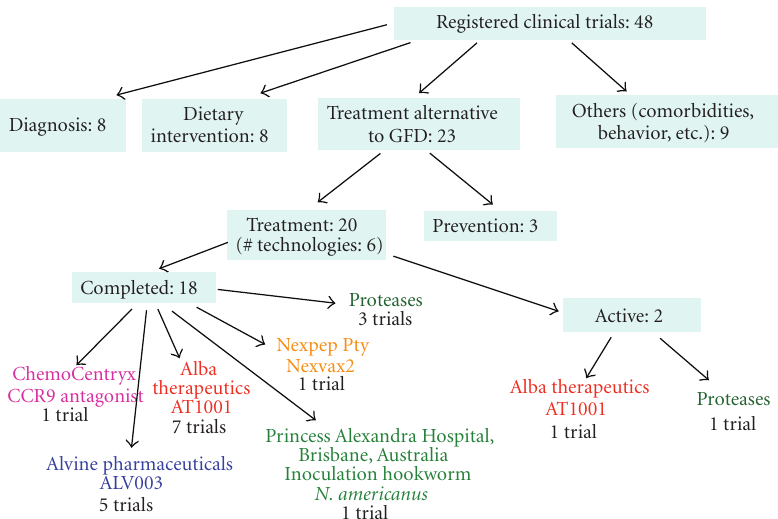
Figure 2: Current clinical trials in celiac disease involving preventive and therapeutic interventions. Data obtained from http:// www.clinicaltrials.gov/ update to July 10th